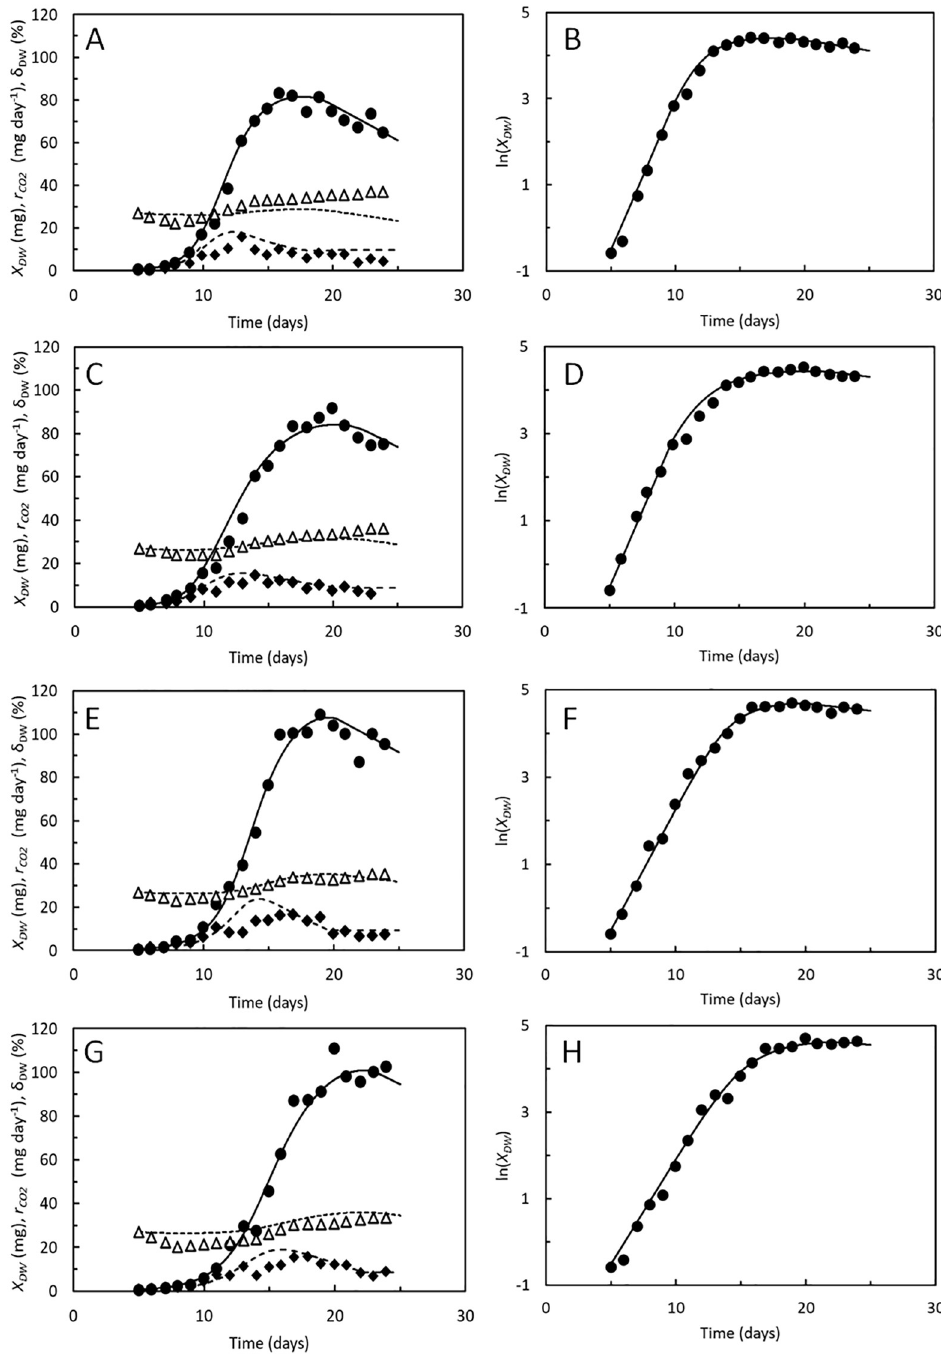
Fig 6. Hermetia illucens. A, C, E, G. Dry weight, X DW ( ● ), dry weight fraction of biomass, δ DW ( △ ), and CO 2 production rate, r CO2 ( ◆ ) of BSF larvae reared on chicken feed with moisture contents of 45% (A), 55% (B), 65% (D), and 75% (G). Logarithmic transformed dry weight ( ● ) of the BSF larvae. Data points from [14]. Curves predicted by the growth model. Parameters shown in Table